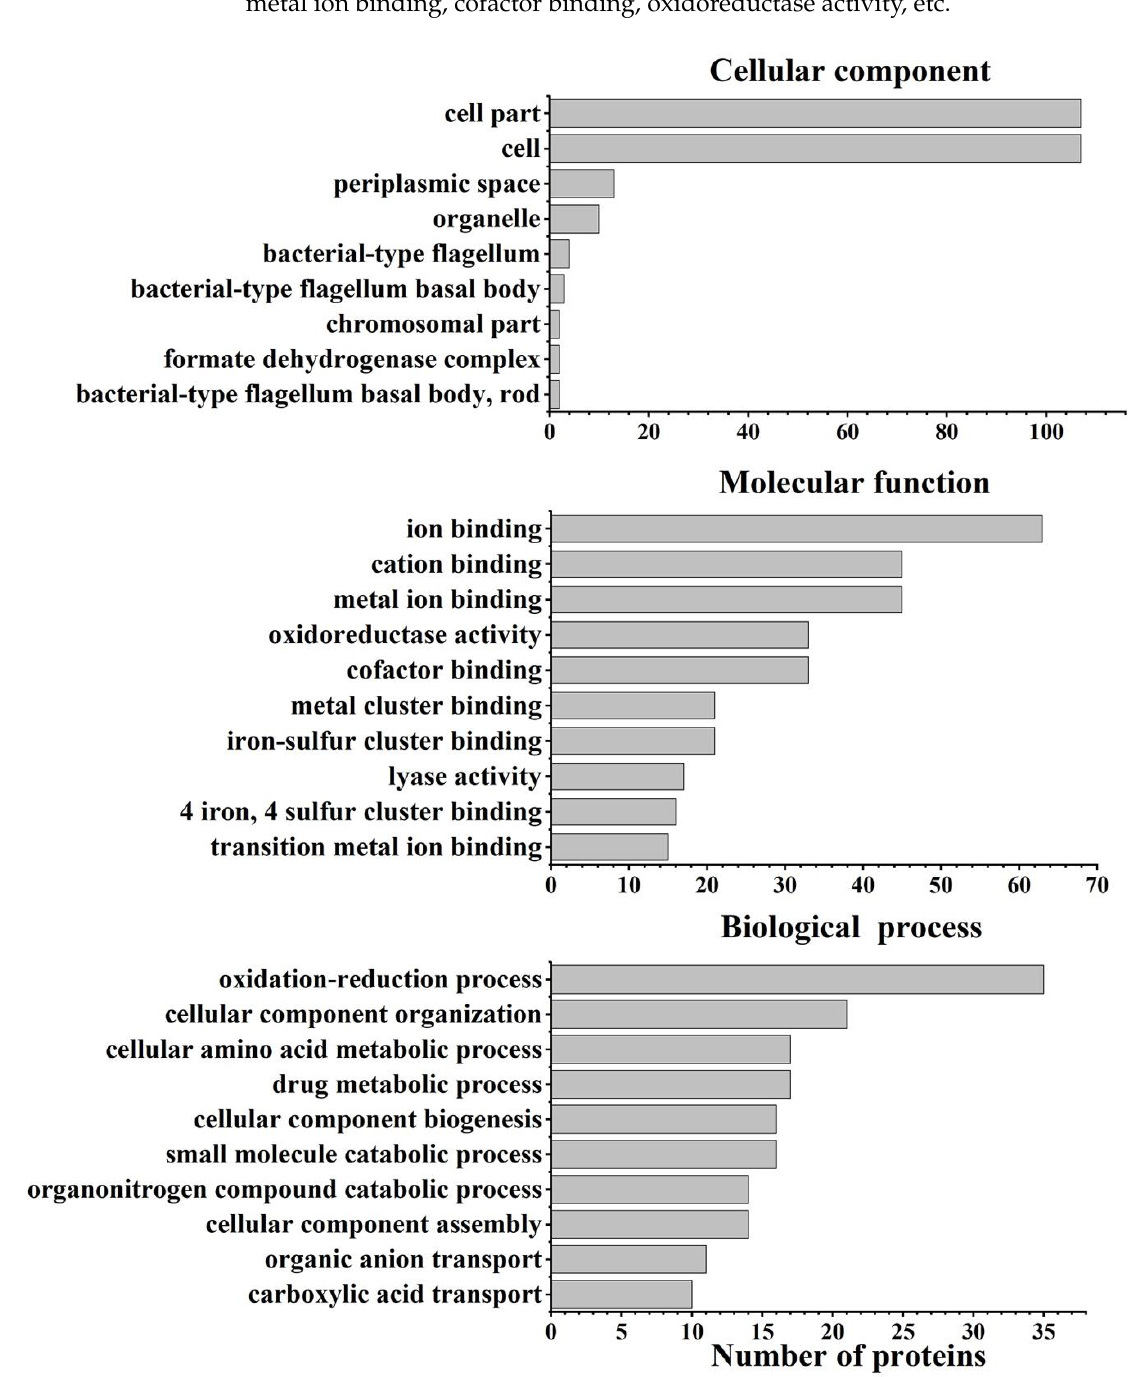
Figure 4. GO enrichment analysis of differentially abundant proteins in S . Enteritidis in response to 130 ppm sodium hypochlorite.